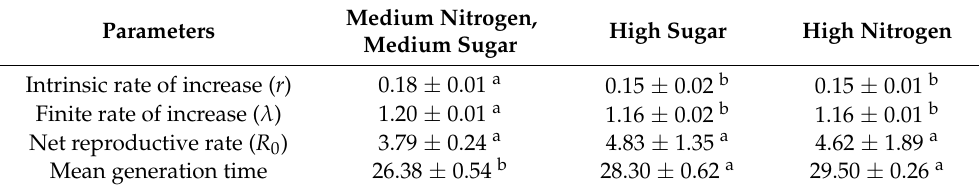
Table 3. Life table parameters of S. exigua population under three nutritional conditions . Parameters